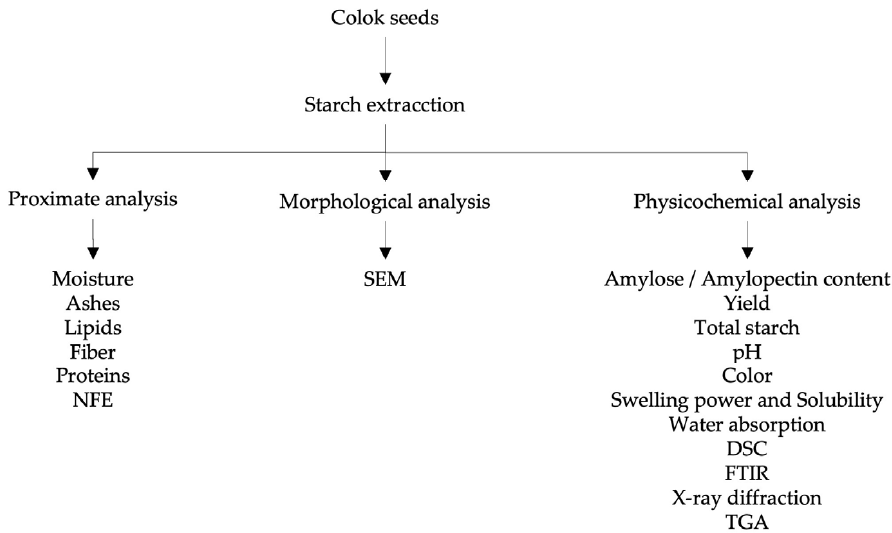
Figure 1. Schematic diagram for the isolation and characterization of Talisia floresii Standl .